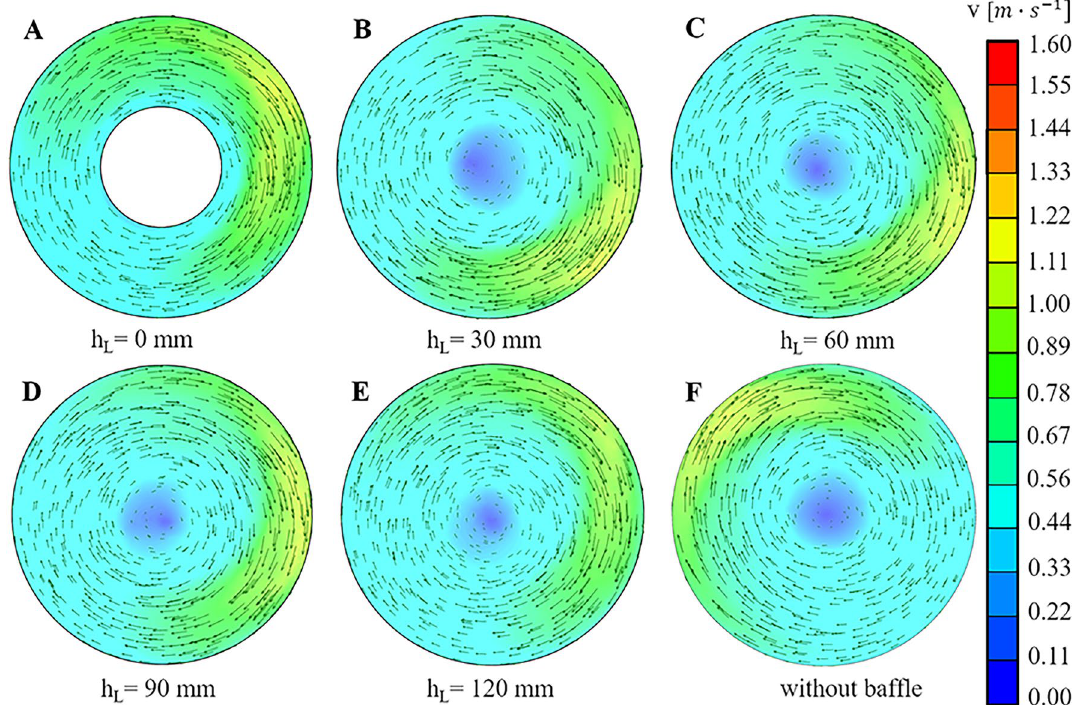
Figure 6. The fluid velocity distribution in fixed horizontal plane of hollow cylinder OSRs with different installation heights. The height between the fixed horizontal plane and the bottom wall of hollow cylinder OSRs was 10 mm.The color bar on the right showed the magnitude of the fluid